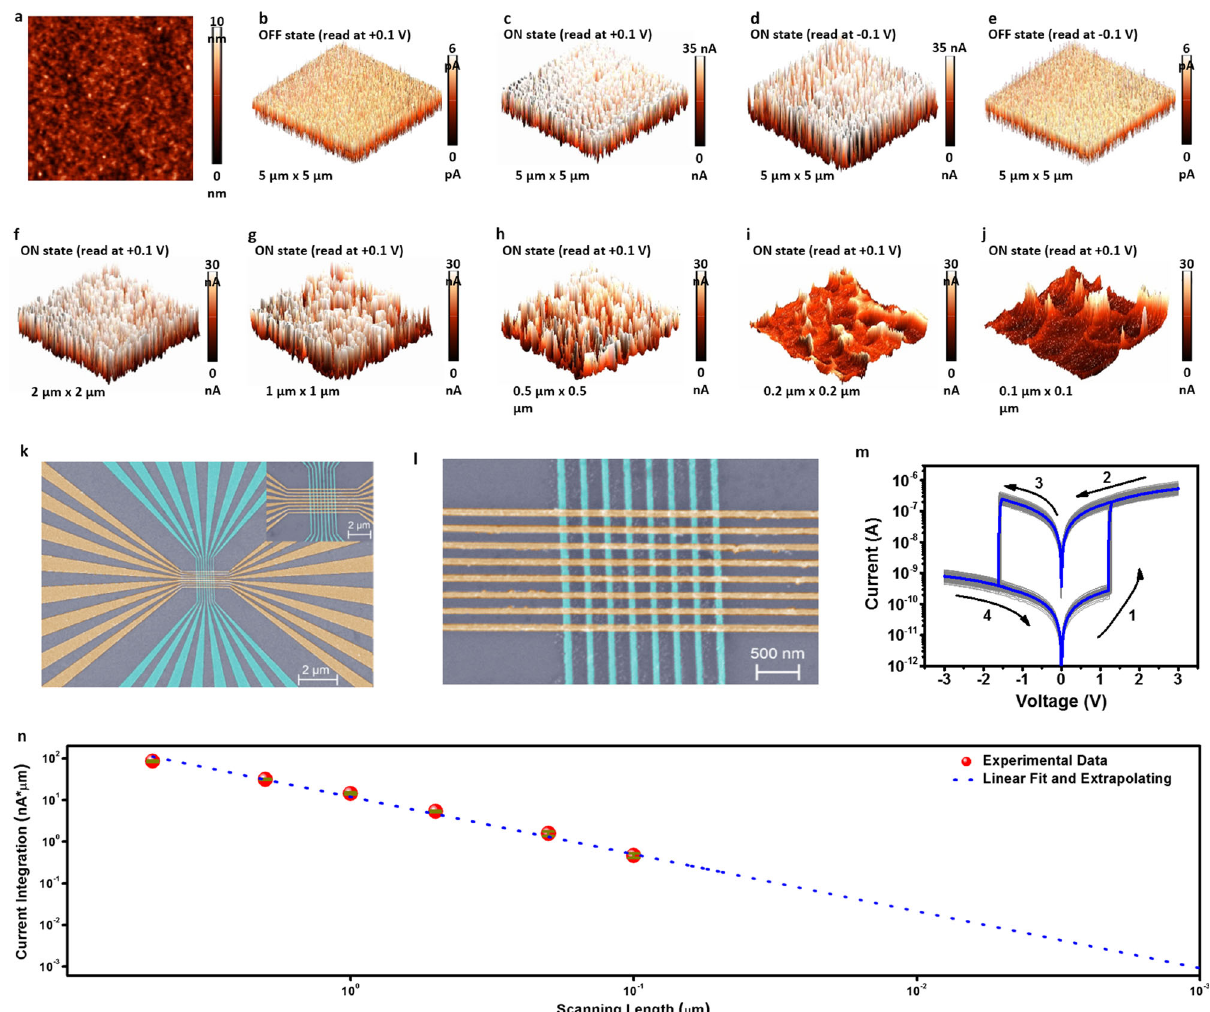
Fig. 3 Bulk switching characteristics, scaling potential, and nano device performance of the 2D conjugated polymer. a Morphology and b – e ON/OFF state current mapping images of the PBDTT-BQTPA thin fi lm over the scanning area of 5 μ m × 5 μ m. f – j ON state current mapping images over the scanning areas ranging from 2 μ m × 2 μ m to 0.1 μ m × 0.1 μ m. k , l Scanning electron images and m cyclic current – voltage characteristics of a